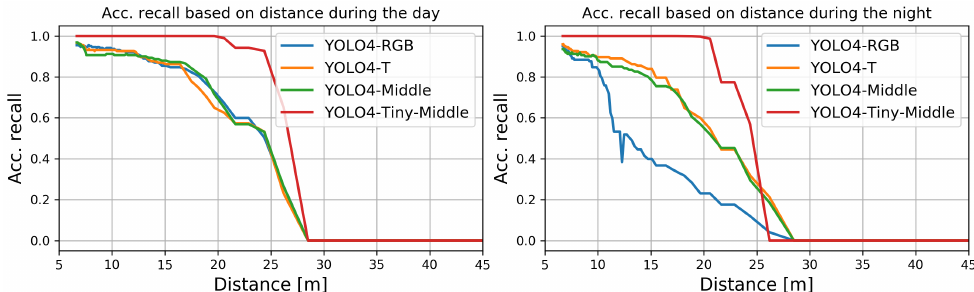
Figure 13. Comparison using the accumulated recall measure over 50 ms. The differences between methods are largely negligible, as better recall results were mostly obtained by more sophisticated methods that are